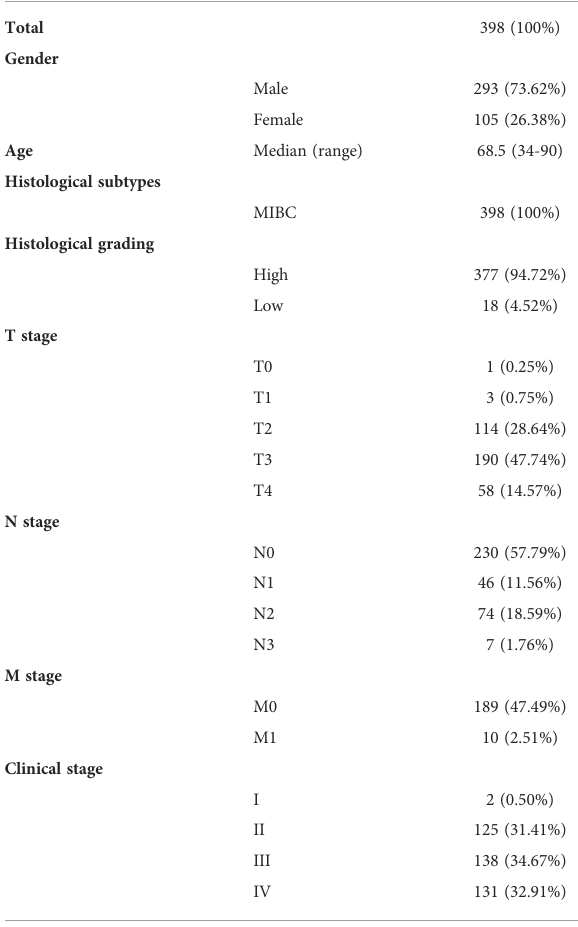
TABLE 1 Clinical features of 398 involved BC patients from the TCGA cohort. Clinical